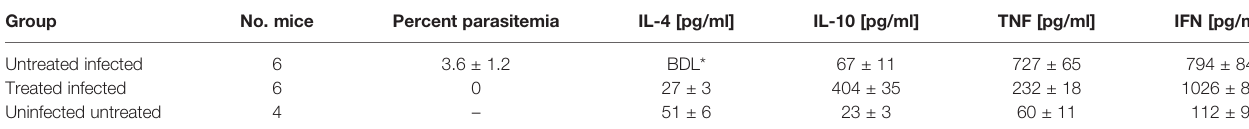
*BDL, below detection